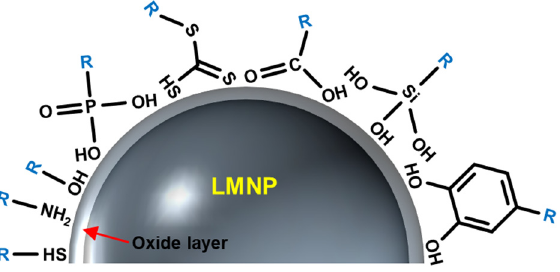
ff erent anchoring groups have been used for grafting the surface of Figure 3. Molecules with different anchoring groups have been used for grafting the surface of LMNPs. Figure 3. Molecules with di